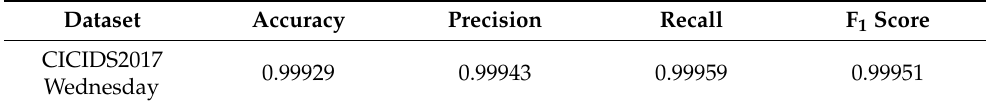
Table 5. Training results on CICIDS2017